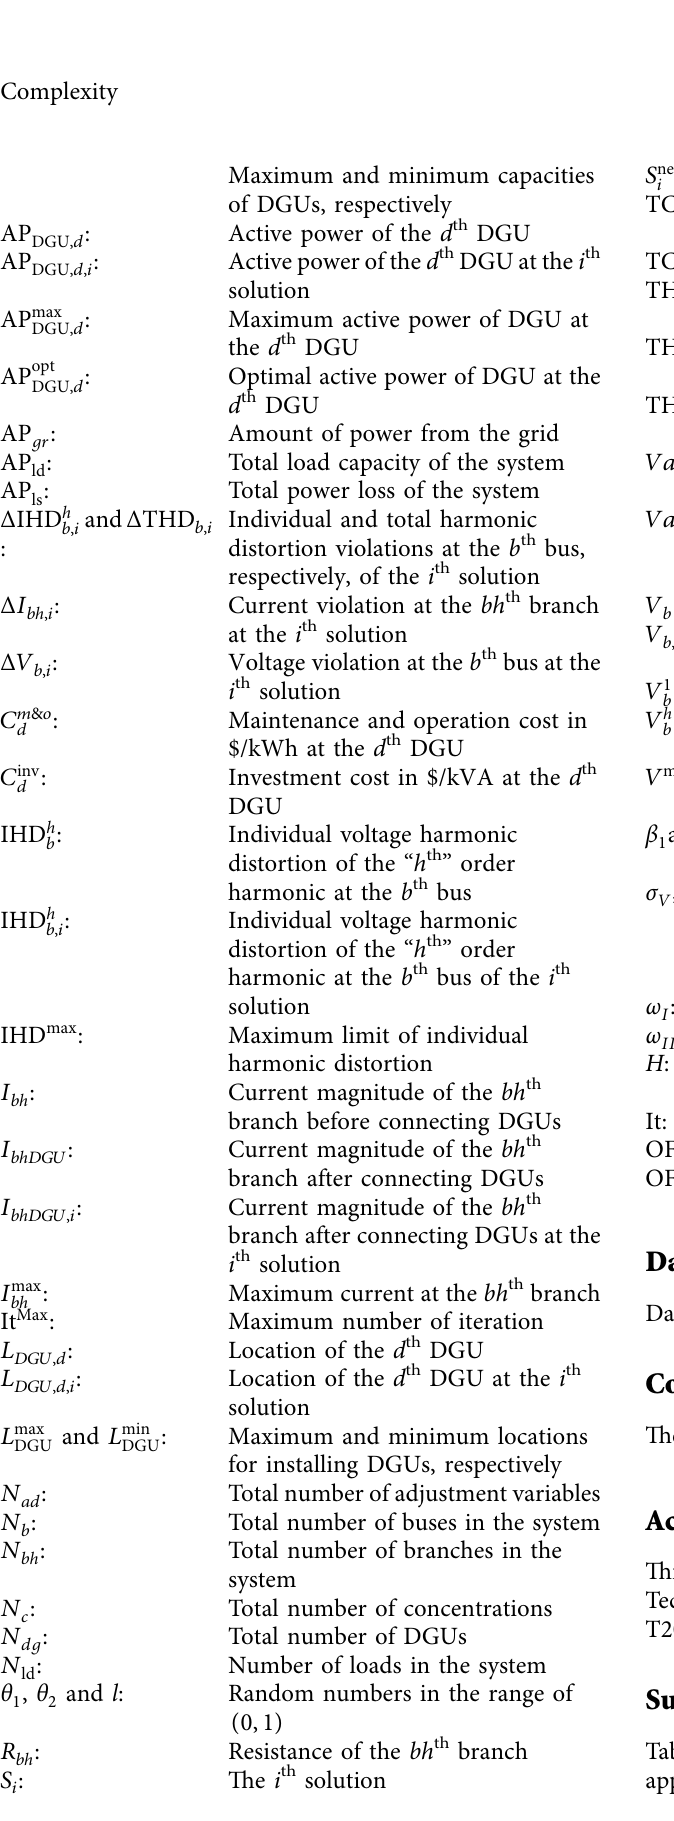
Table S1, Table S2, and Table S3: optimal solutions of the applied systems. ( Supplementary Materials